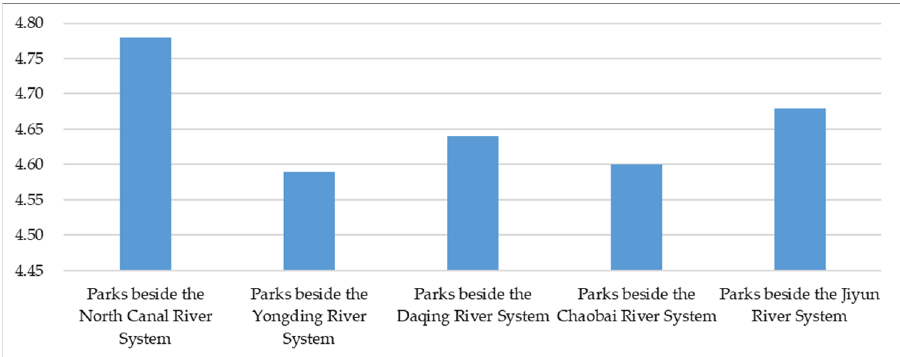
Figure 5. The average stars of riverside parks beside different river systems.